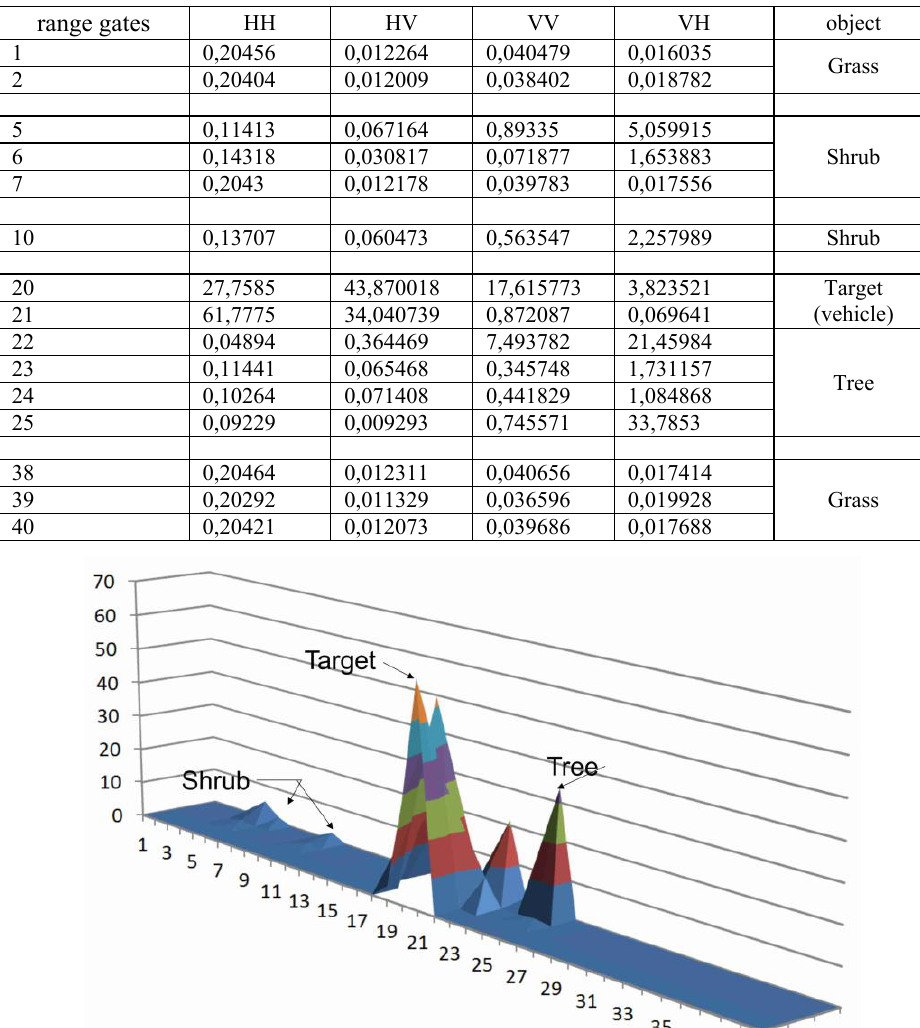
Table 4. Observation contributions for the scene with the target.